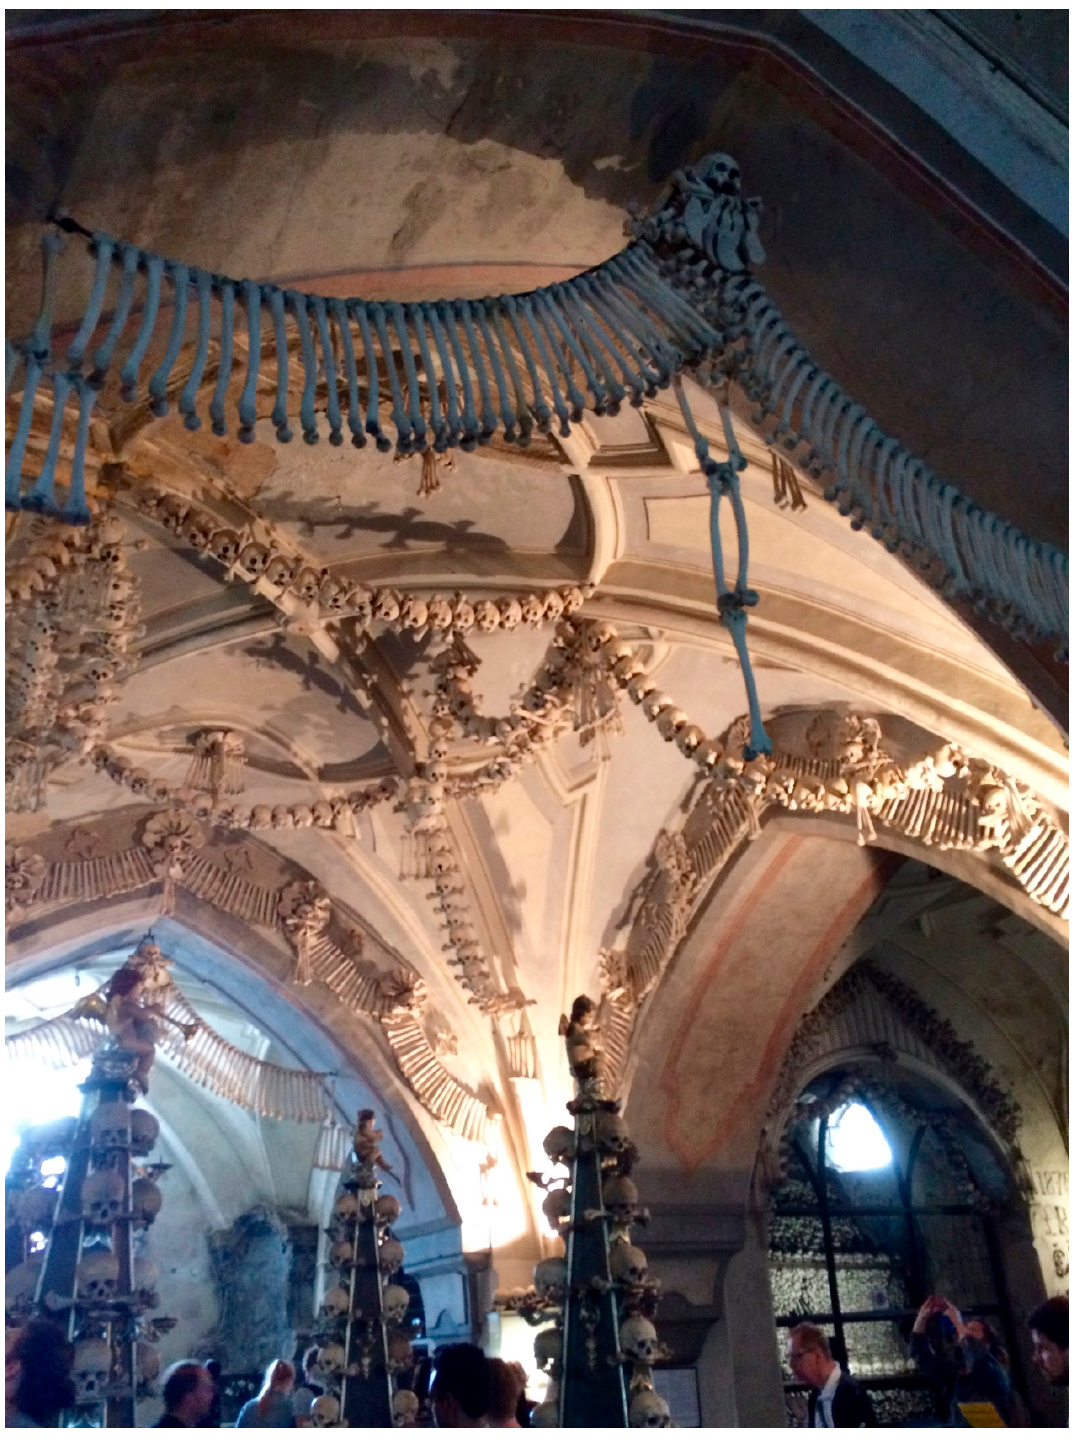
Figure 4. Sedlec Ossuary, ceiling decoration, and tourists, interior, May 2016. Kelsey Perreault.